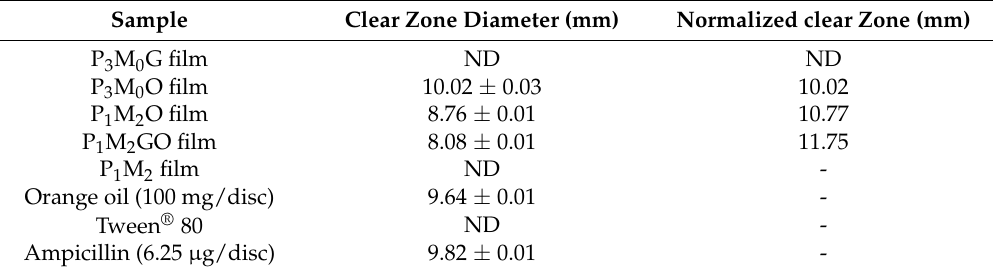
Table 4. Anti-bacterial activity of films against S.